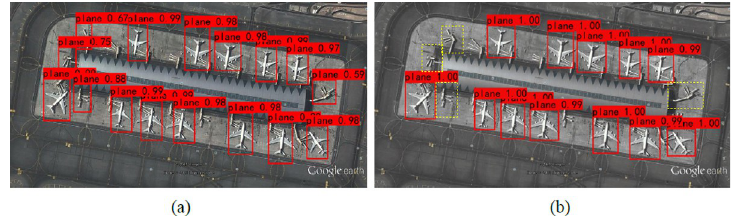
Fig 11. SR-YOLO and YOLOv3’s detection of plane images with instance-level noise, the yellow box marks the objects that the YOLOv3 network false detection as the plane. (a) The results of YOLOv3 algorithm detection; (b) The results of SR-YOLO algorithm detection.